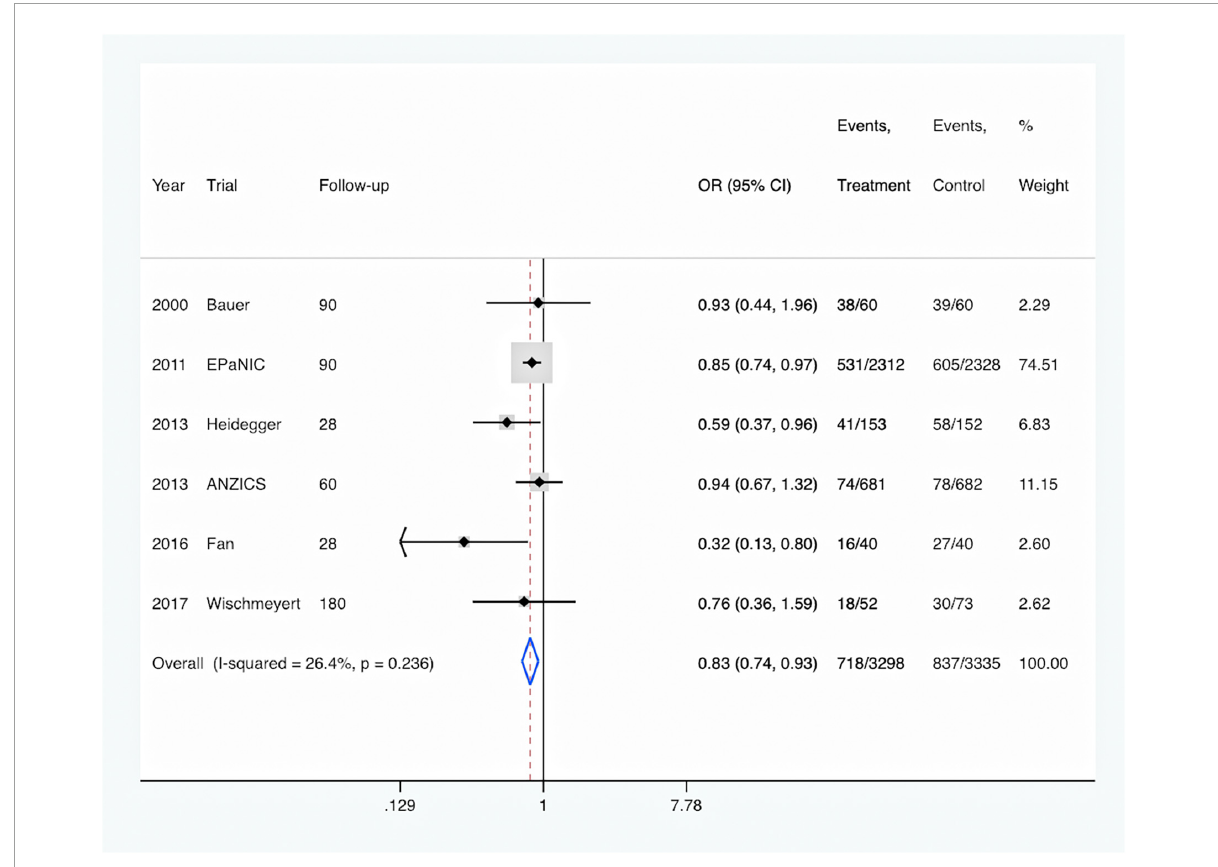
FIGURE4 Effect of SPN and EN nutrition support treatment on infection rate.